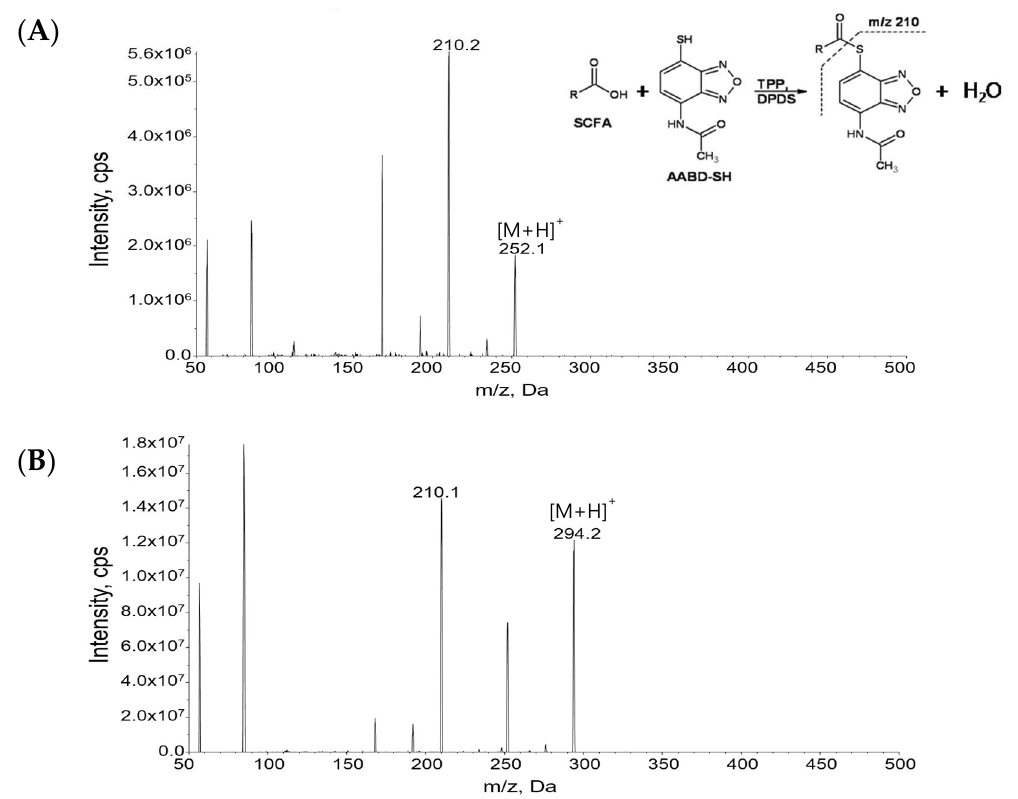
Figure 1. Tandem mass spectrometry (MS/MS) spectra of ( A ) derivatized acetic acid (C2) and ( B ) derivatized valeric acid (C5). Collision energies were 15 V.